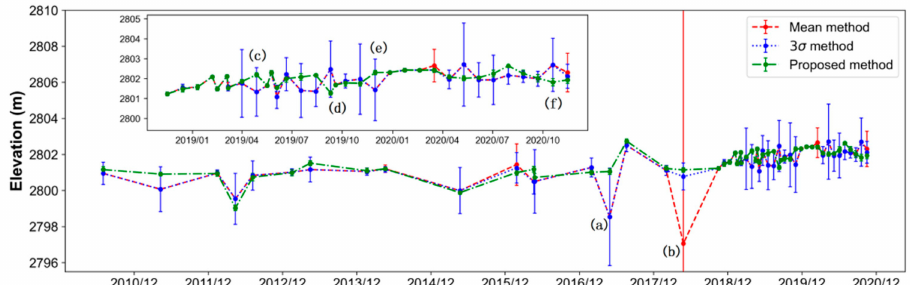
Figure 16. Water levels of Gahai Lake extracted by different methods on ( a ) 29 May 2017, ( b ) 27 May